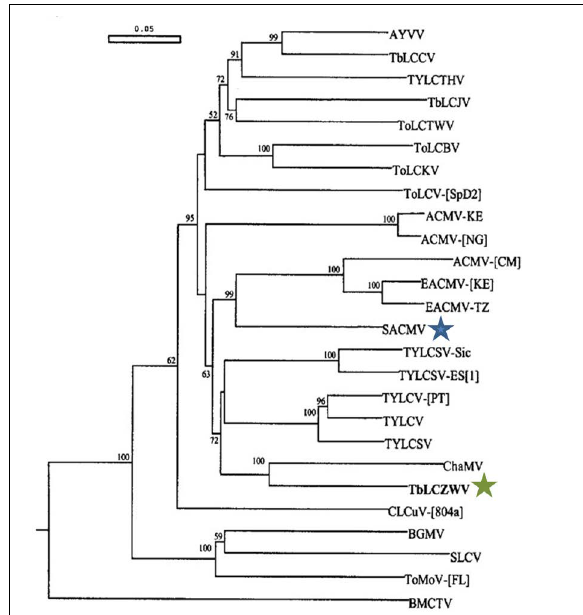
Figure 3: Relationship dendrogram of the DNA A nucleotide sequences of Tobacco leaf curl Zimbabwe virus (TbLCZWV) and other geminiviruses. Bootstrap scores >50% were placed at major nodes, and nodes lacking a score are considered dubious. Geminiviruses and their respective GenBank accession numbers are as follows: ACMV-[CM] ( African cassava mosaic virus–Cameroon : NC 000859); ACMV-[KE] ( African cassava mosaic virus–Kenya : J02057); ACMV-[NG] ( African cassava mosaic virus–Nigeria : X17095); AYVV ( Ageratum yellow vein virus : X74516); BMCTV ( Beet mild curly top